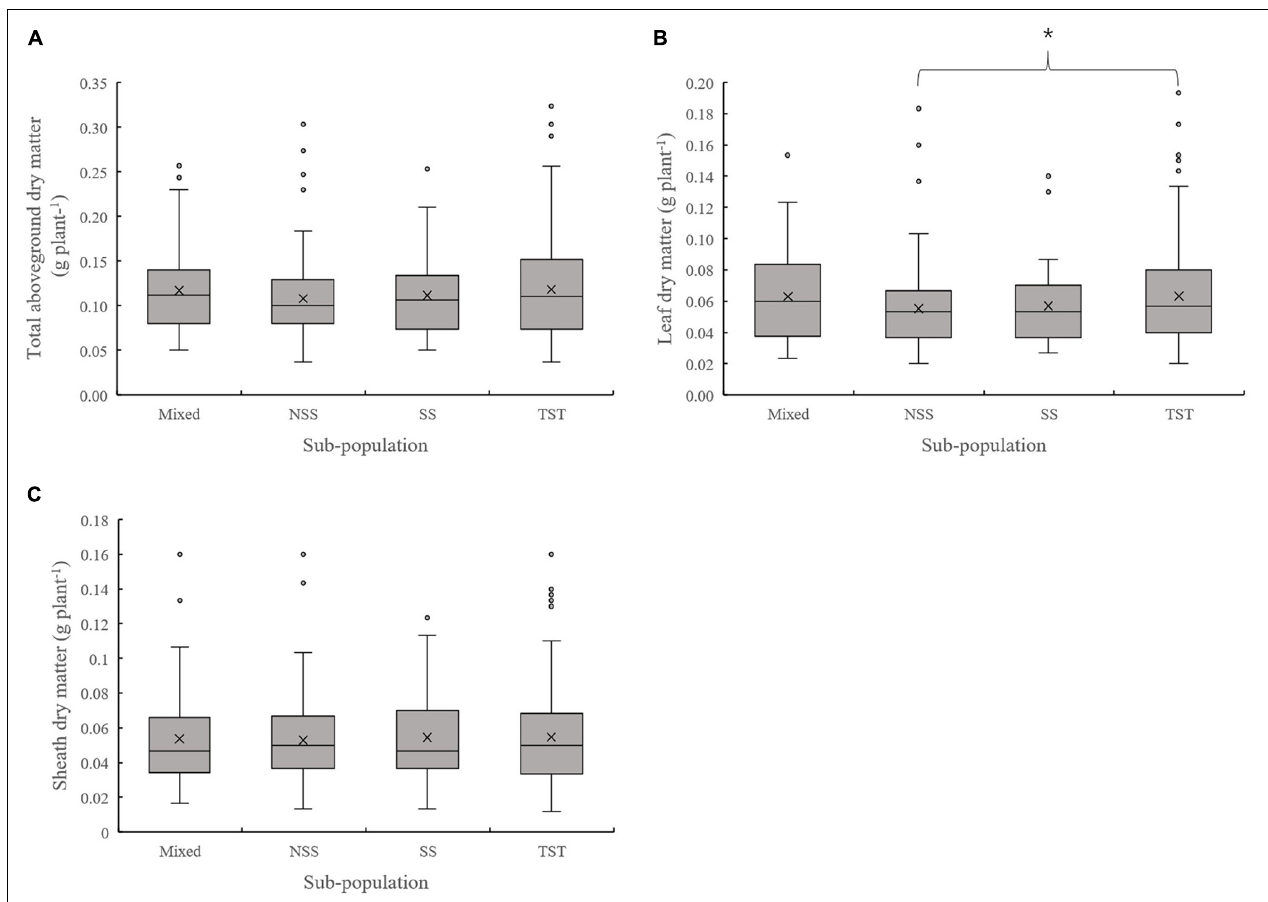
FIGURE 1 | Boxplot of the total aboveground dry matter and organ’s dry matter of different subpopulations at the V3 stage. * denotes significant differences between subpopulations at P ≤ 0.05. (A–C) represent the Total aboveground dry matter, Leaf dry matter and Sheath dry matter of different subpopulations respectively.